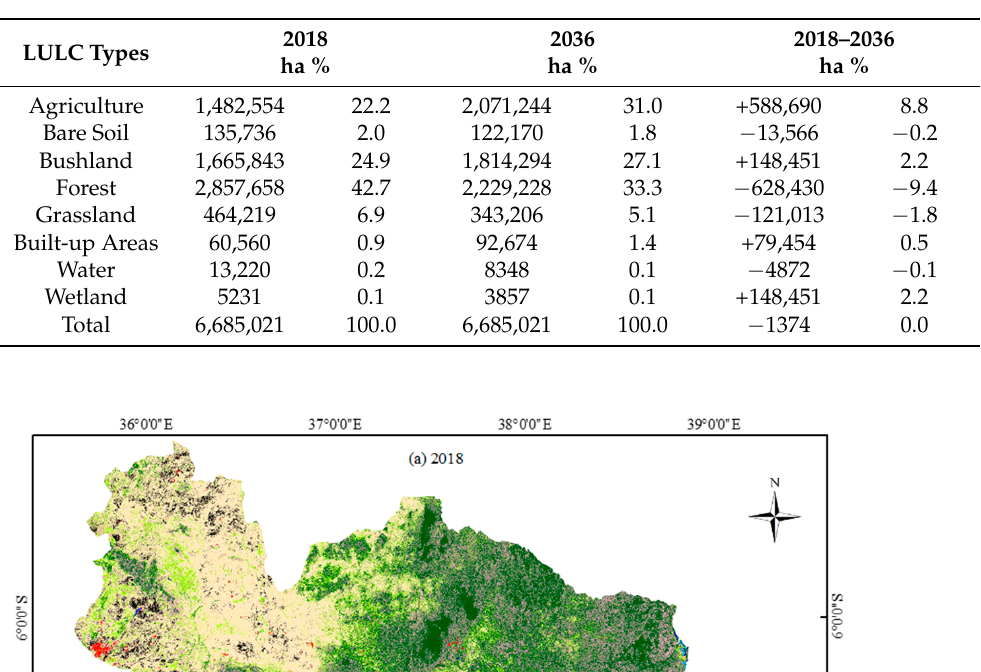
Table 8. The CA–Markov model LULCC results for the year 2018, 2036 (projected), and 2018–2036, showing area change (+Gain and − Loss) in the WRB.